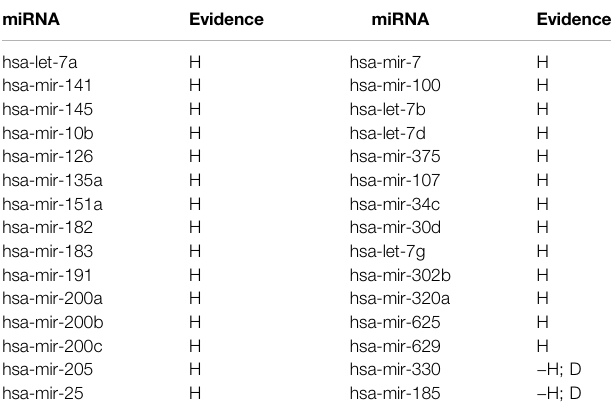
TABLE 3 | The top 30 potential miRNAs associated with breast neoplasms.